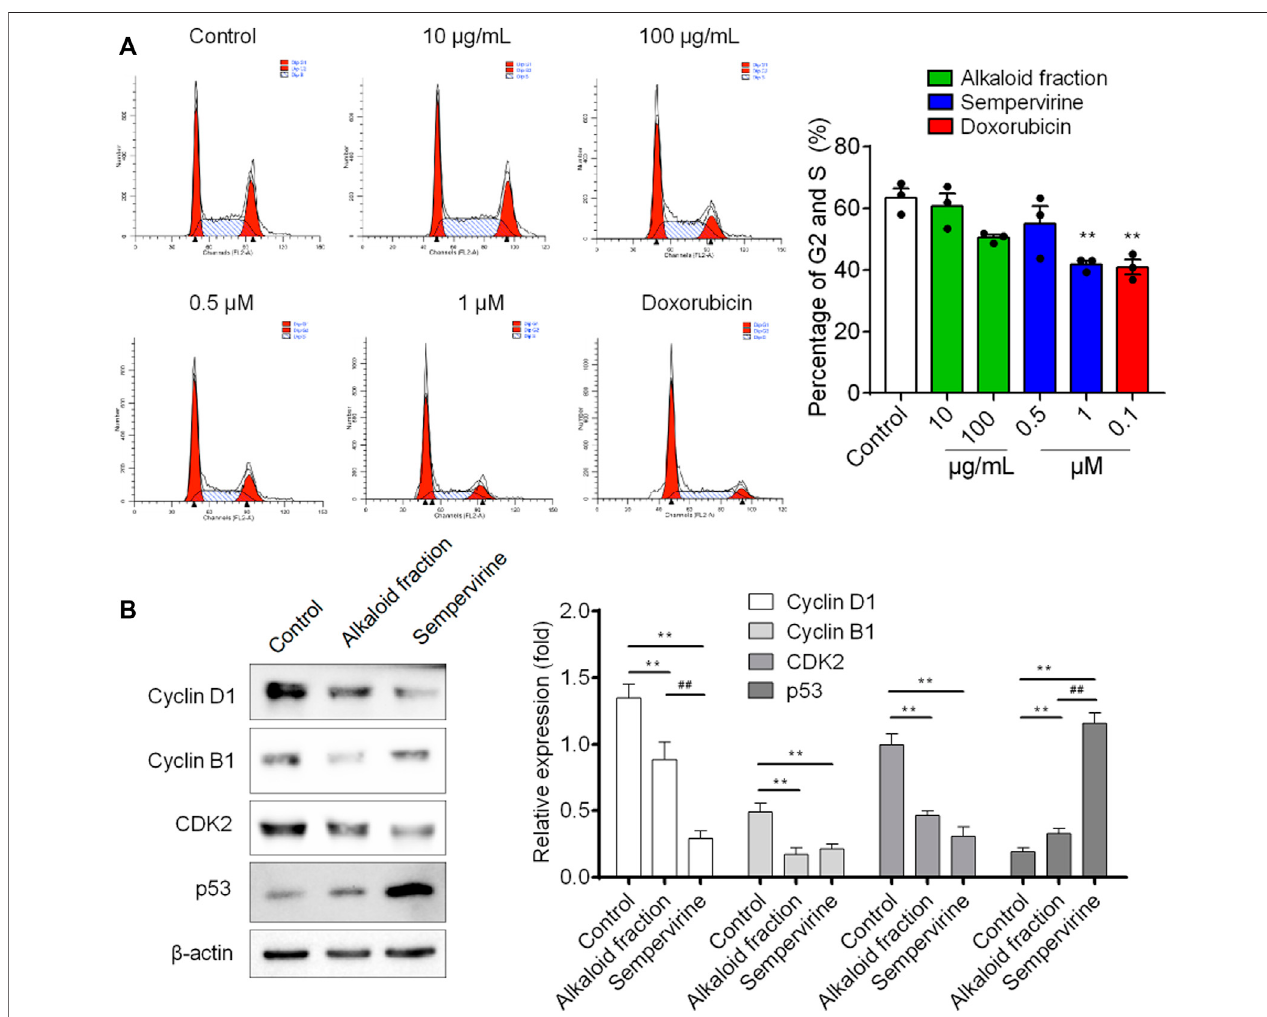
FIGURE 4 | The effect of sempervirine on the cell cycle and the expression of cell cycle regulators in HepG2 cells. (A) Sempervirine treatment induced a dose dependent increase in the proportion of cells in the G1 phase and a decrease in cells in the S and G2 phases compared to the control. (B) Representative pictures for p53, CDK2, cyclin B1 and cyclin D1 protein expression by western blot analysis. ** p < 0.01 vs . Control, ## p < 0.01 vs . the alkaloid fraction.